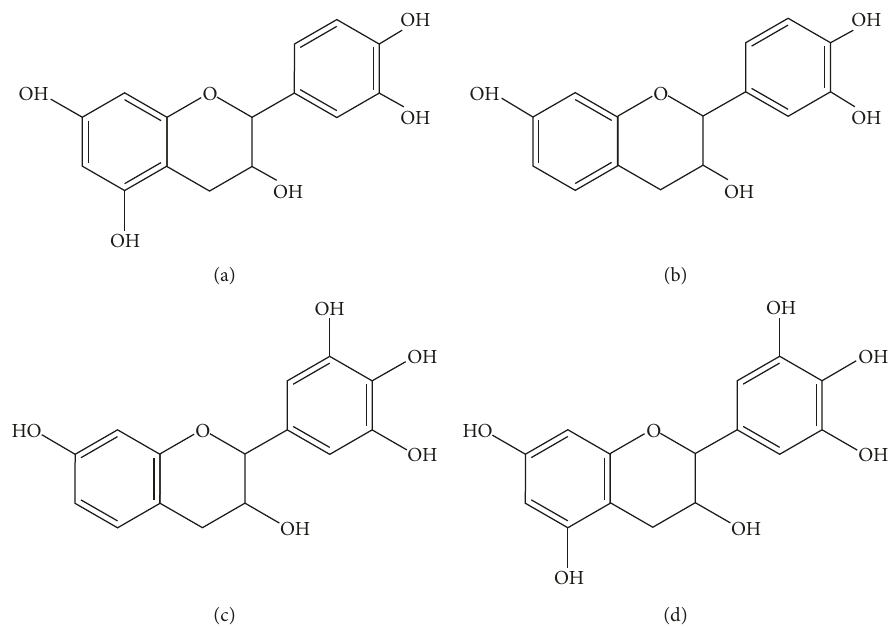
Figure 2: Chemical structure of (a) (epi)catechin, (b) (epi)fisetinidol, (c) (epi)robinetinidol, and (d)